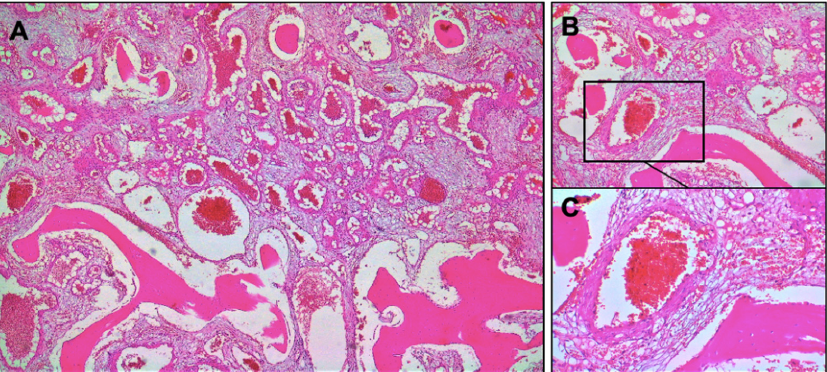
Figure 4. Microscopical images related to the histological investigation—general aspects of the tissue, hematoxylin and eosin (H&E) section: ( A ) Tumoral proliferation formed of venous blood vessels and trabecular bone tissue (H&E, × 4 original magnification); ( B ) bone lamellae replaced by proliferation of blood vessels in a myxoid matrix (H&E, × 10 original magnification); ( C ) bone lamellae that present a row of osteoblasts on the edge and a sanguine vessel of venous type disposed in a myxoid matrix (H&E, × 20 original magnification).